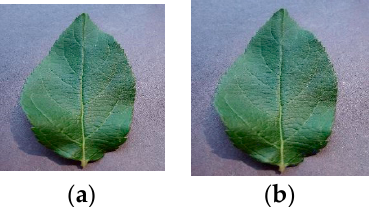
Figure 11. Gaussian noise: ( a ) initial, ( b ) Gaussian noise.